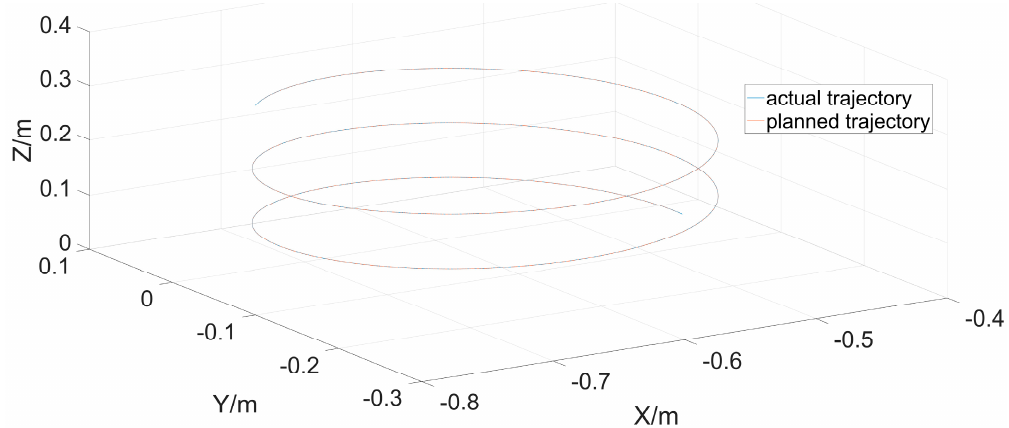
Figure 18. Robot end trajectory.